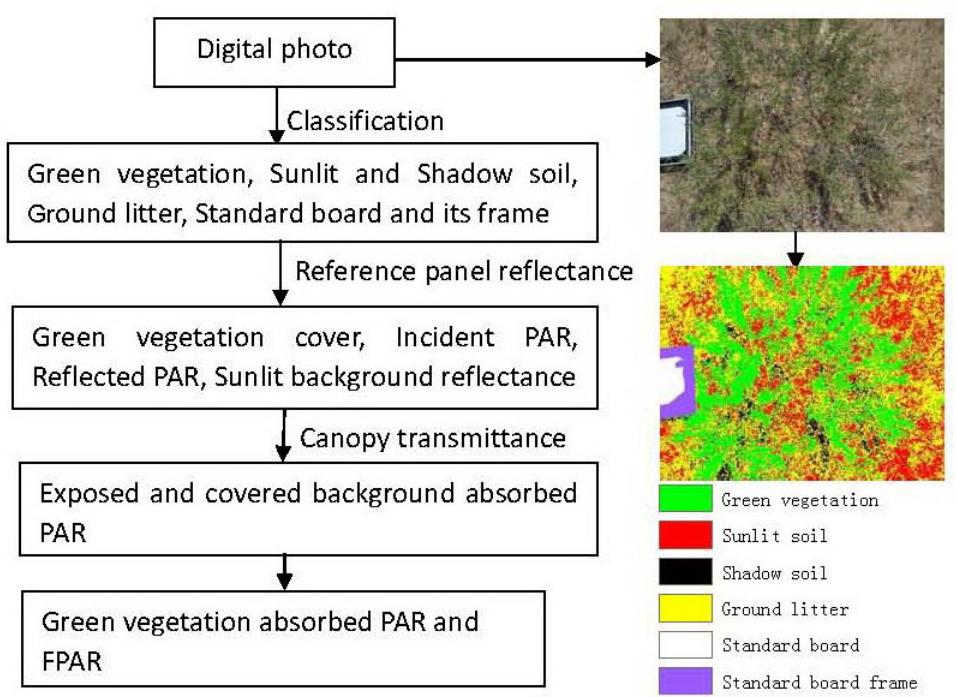
Figure 2. Diagram of green vegetation FPAR estimation based on a digital camera photo. The photo was taken vertically at a height of 1.5 m in the digital camera’s raw file format, and the area was about 2 m 2